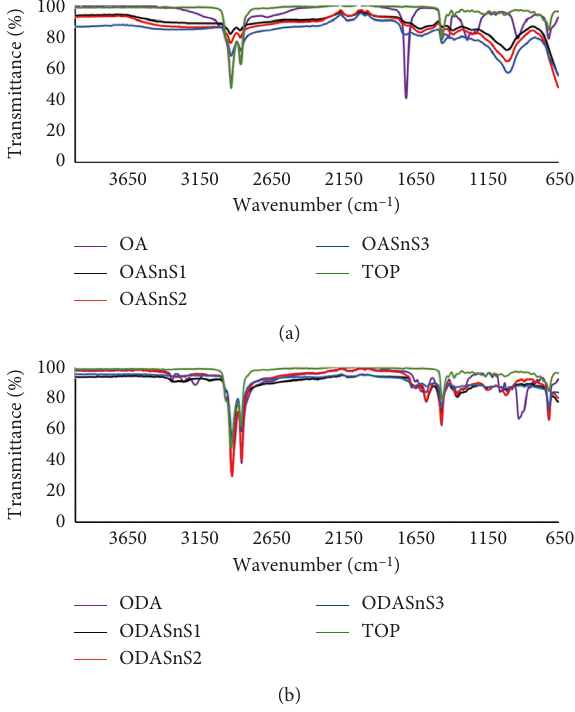
Figure 8: FTIR spectra overlay of OASnS nanocrystals (a) and ODASnS nanocrystals